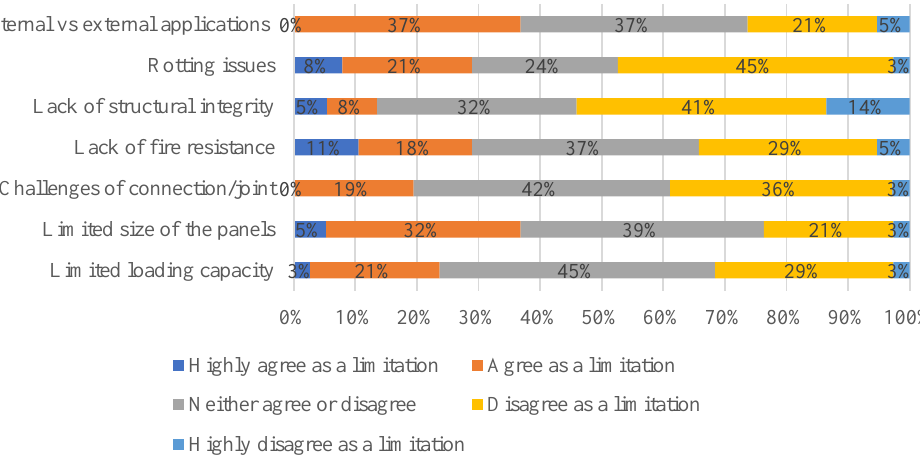
Figure 5. Technical and performance limitations for MTC products.